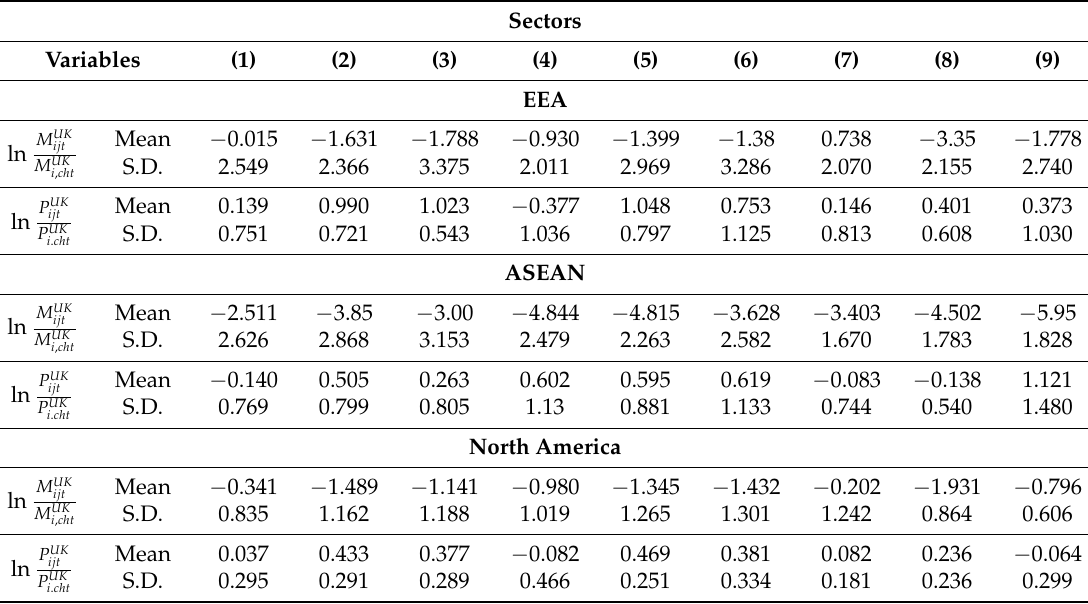
Table 9. Data description of Equation